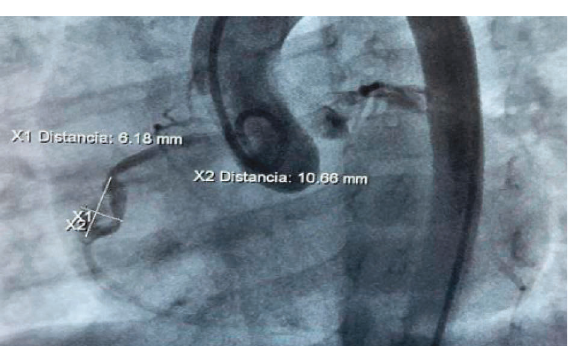
Figure 3: Cardiac catheterization: Intracoronary thrombus oc- cupying 2/3 of the aneurysmal lumen in the middle third of the right coronary artery.